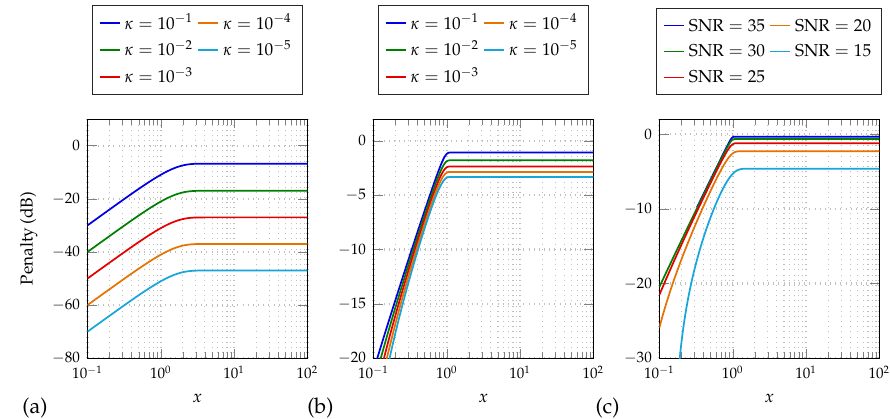
Figure A2. Penalties corresponding to asymptotic cases: ( a )no coherent contributions, σ = 1, Rayleigh approximation; and high signal-to-noise ratio, Gaussian approximation holds: ( b )varying κ , ρ = 20, ( c )varying SNR, κ = 0.01.